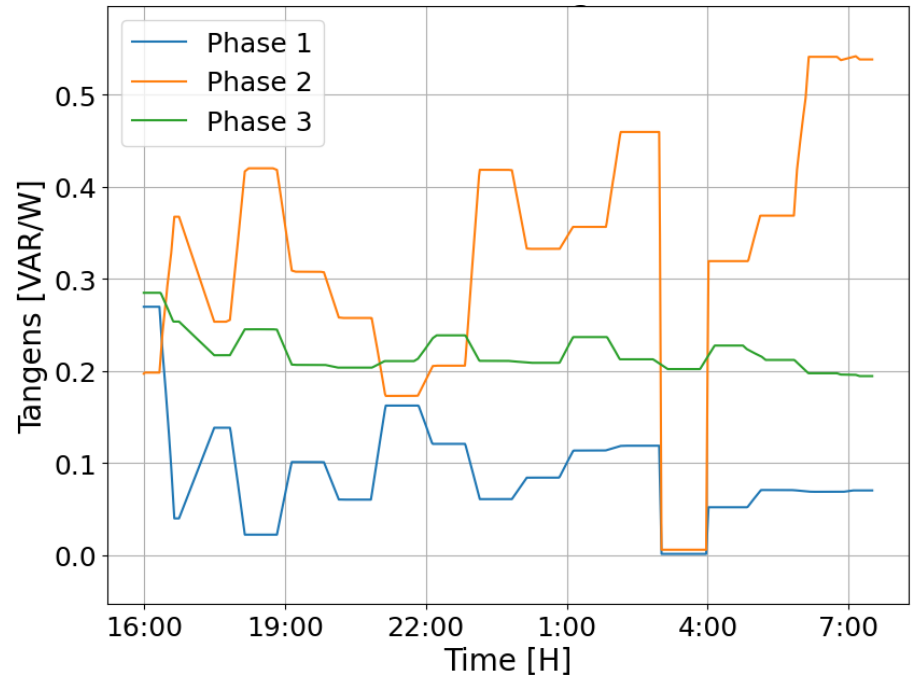
Figure 9. Characteristic of changes in the values of tg φ coefficients—luminaires with discharge sources (without reduction). Source: own